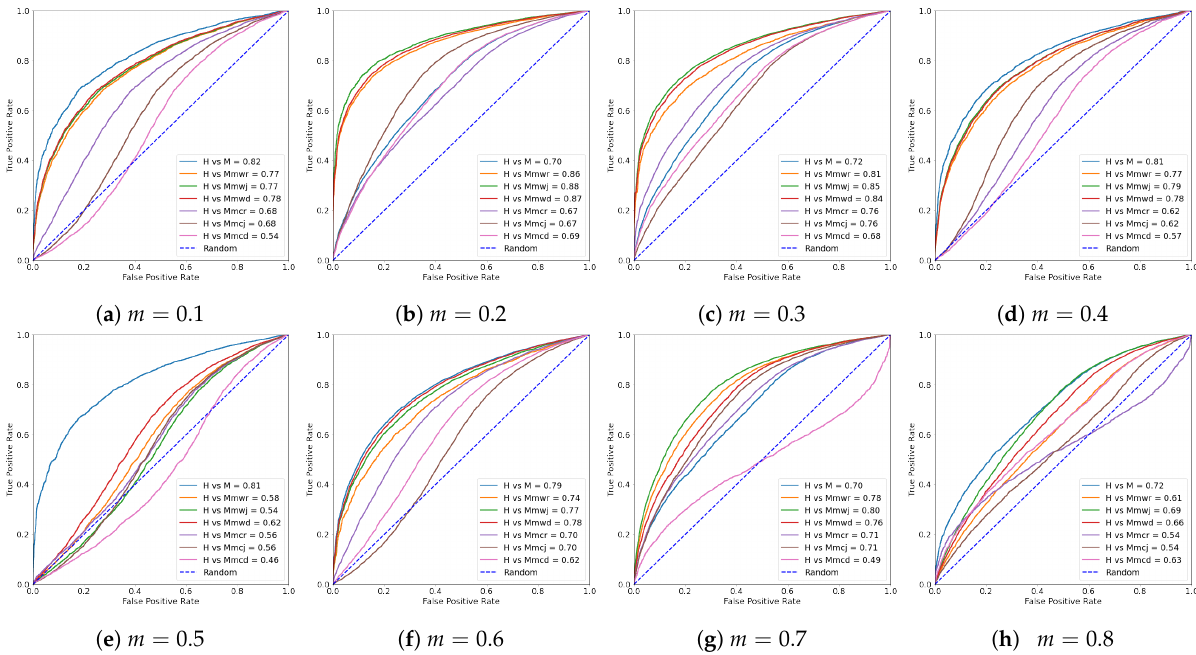
Figure 7. Effect of random removal ratio (i.e., m ) for